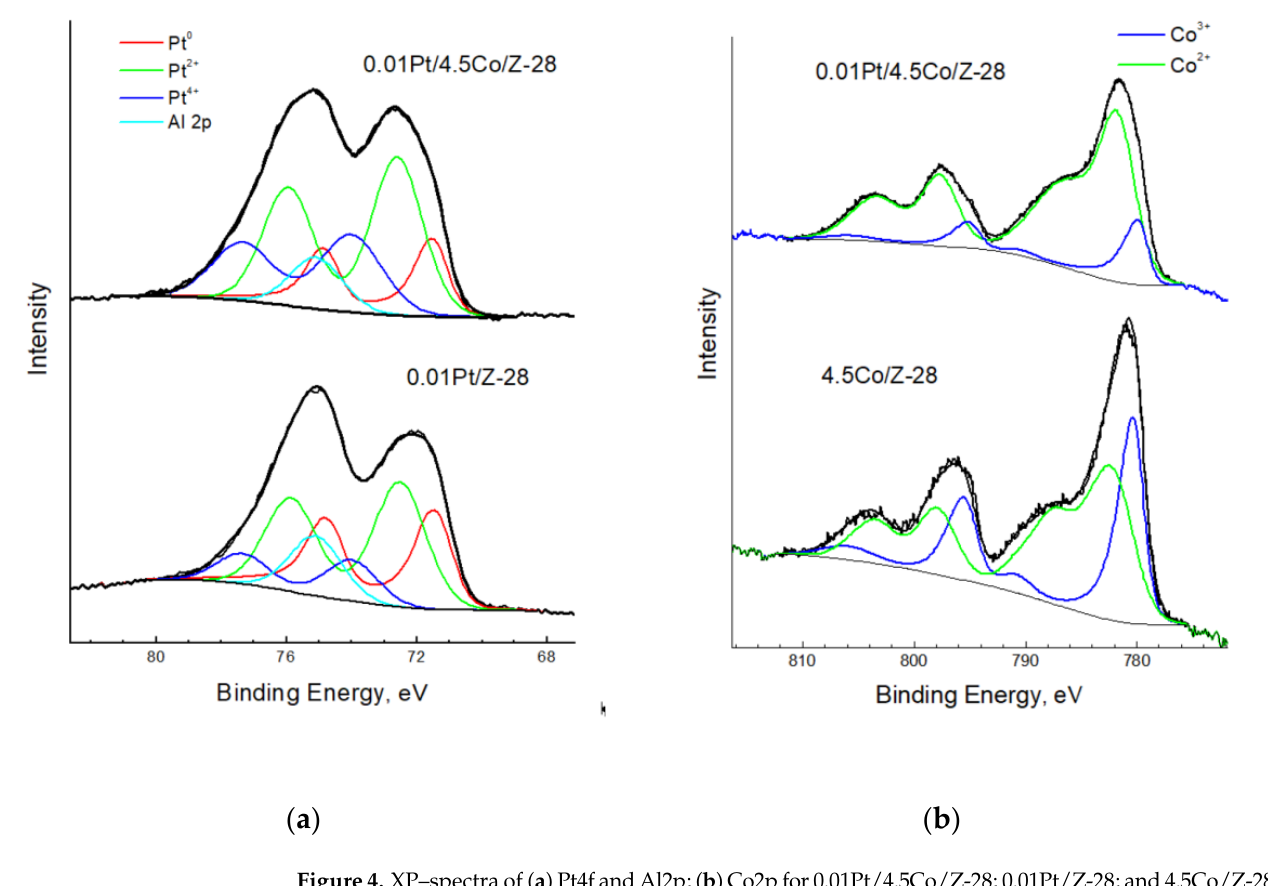
Table 3. Binding energies (eV) of the XPS components in the spectra of Pt- and Co-modified zeolites (BE Si2p=103.6eV).